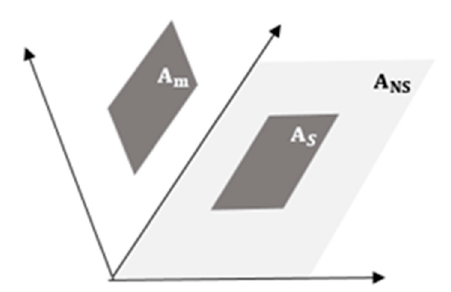
Figure 3. The components of the reflected radiation to the rear side.